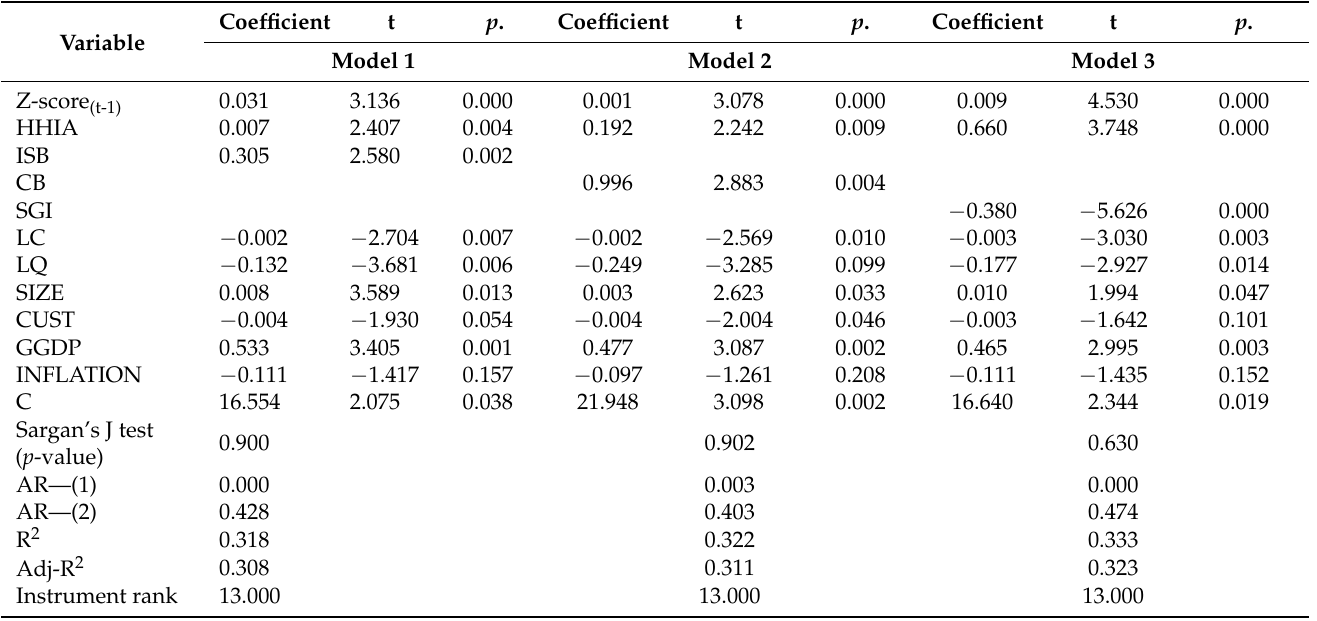
Table 9. Effects of competition (based on HHIA), loan quality and ownership structure on financial stability.